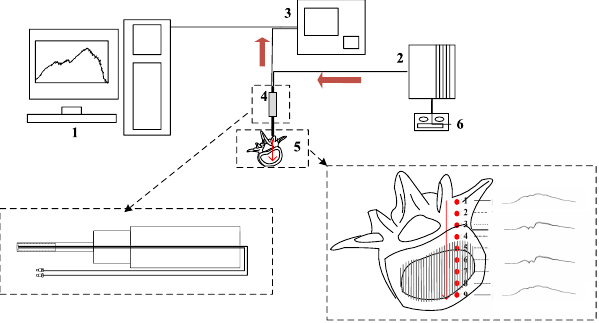
Fig. 1. The measurement system for spectrum on the verte- bral bone model: 1: computer, 2: light source, 3: spectrometer, 4: ¯ber optic probe, 5: vertebral bone model, 6: